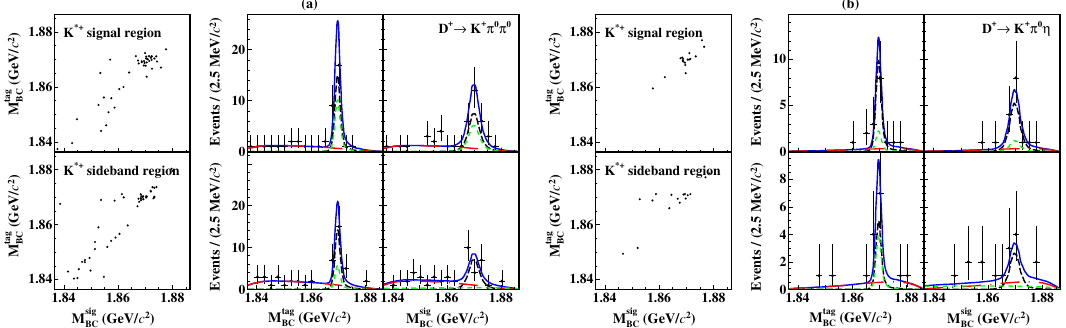
versus M sig and the projections on (middle Figure 3 . Distributions of (left column) M tag BC BC column) M tag and (right column) M sig of the constrained 2D fits to the DT candidate events BC BC in the K ∗ + signal region (top row) and sideband region (bottom row) for (a) D + → K + π 0 π 0 and (b) D + → K + π 0 η . Points with error bars are data. Blue solid curves are the fit results. Black dotted curves are the signal distributions. For the K ∗ + sideband region, green dotted and red dot-long-dashed curves are BKGI and BKGII, respectively. For the K ∗ + signal region, red dot-long-dashed curves are BKGII and green dotted curves are the peaking backgrounds constrained by using the K ∗ + sideband